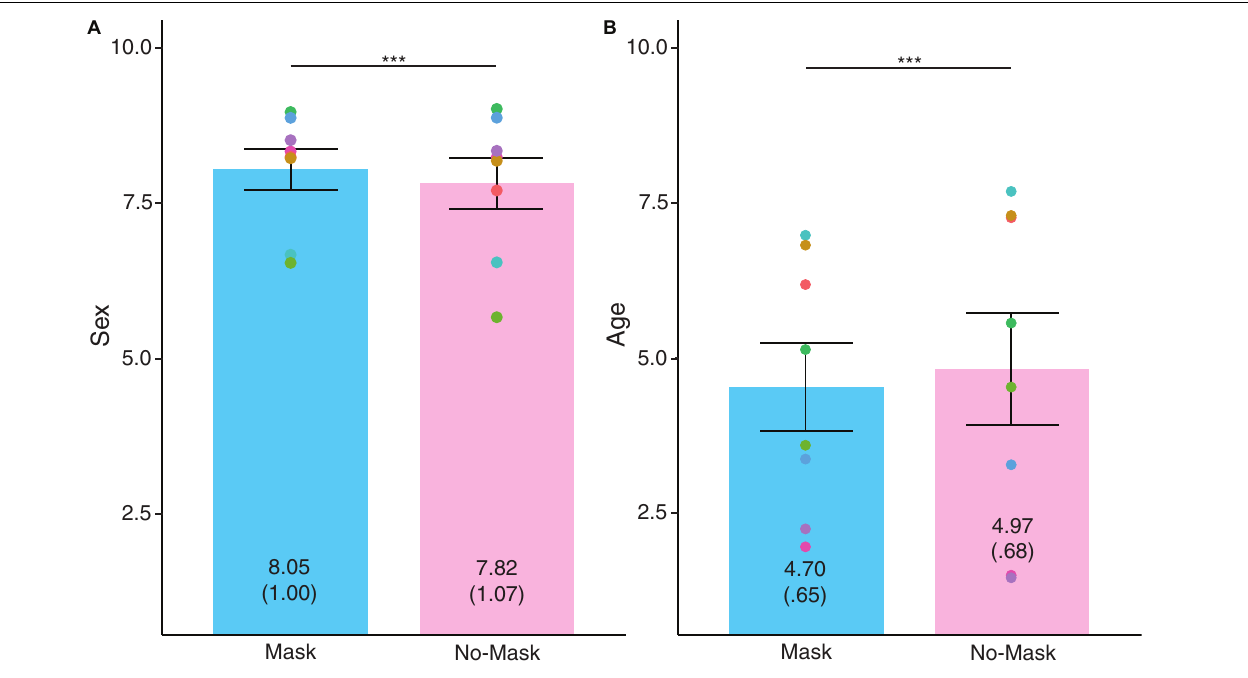
FIGURE 2 | Ratings for invariant characteristics of (A) SEX DV and (B) AGE DV . Individual points represent averaged rating for each face. The values depicted in each bar refer to the mean ratings and the standard deviation is in parenthesis. Error bars indicate standard error means (SEM). Higher values indicate more accurate in (A) and older in (B) . *** p > 0.001, ** p > 0.01, * p > 0.05.